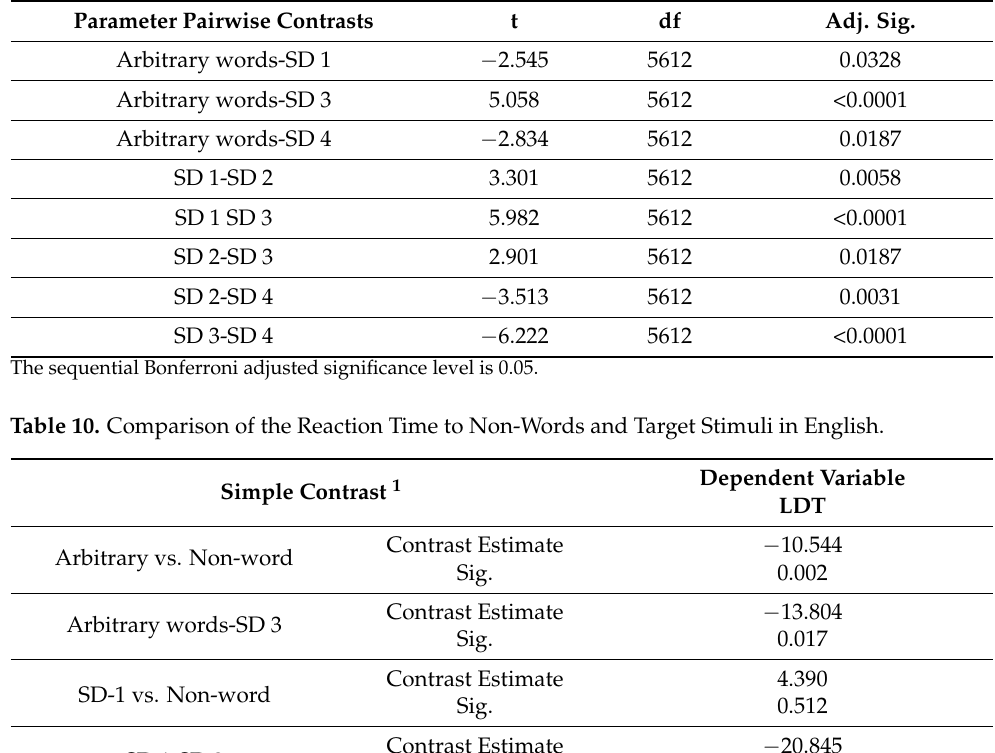
Table 9. Statistically significant results of Post-Hoc pairwise comparisons for the levels of the factor Parameter (Russian-speaking sample).